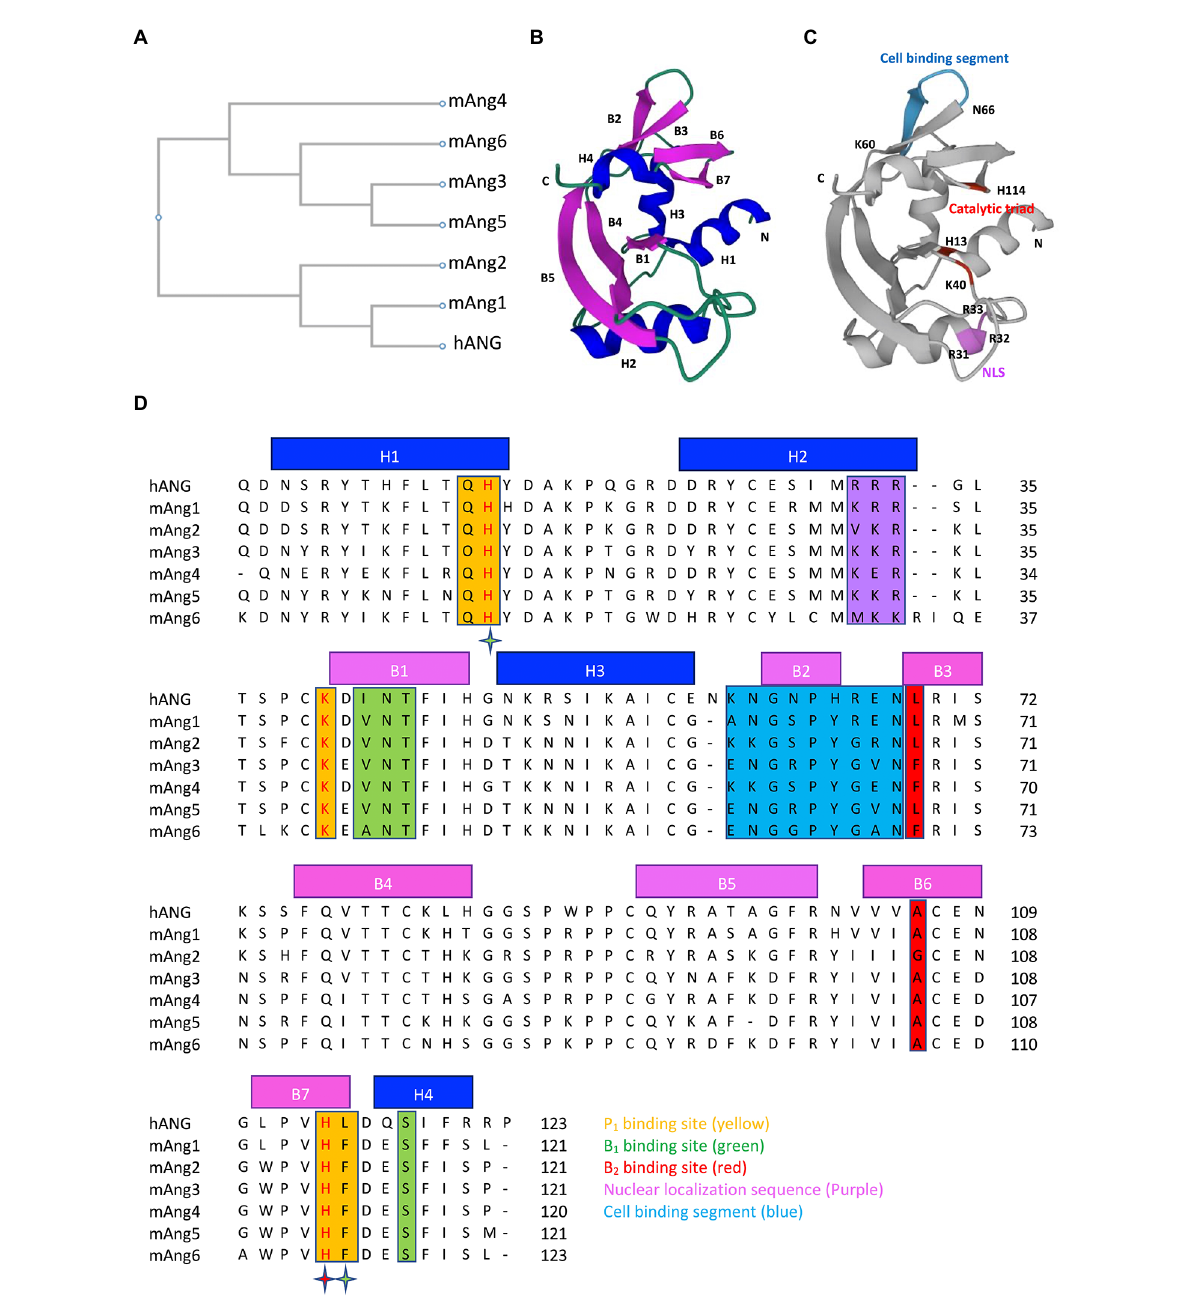
FIGURE 1 Phylogenetic tree, 3D structure and sequence alignment of angiogenins. (A) Phylogenetic tree of hANG and mAngs. (B) Three-dimensional structure of hANG (PDB entry 1B1I) labelled with secondary structures, α -helices (blue), and β -strands (purple). (C) Three-dimensional structure of hANG labelled with different functional sites, catalytic triad (red), NLS (purple), and cell-binding segment (blue). (D) Sequence alignment of the hANG and mAngs. Secondary structures are indicated by blue line ( α -helices) and purple line ( β -strands). Residues that form the putative substrate-binding subsites are highlighted as follows: P 1 subsite residues (yellow), B 1 subsite residues (green), and B 2 subsite residues (red). The stars highlight the active site residues that belong to two subsites and are colored according to the subsite. Residues that form the NLS and cell-binding segment are highlighted in purple and blue color, respectively. The phylogenetic tree and sequences were aligned using